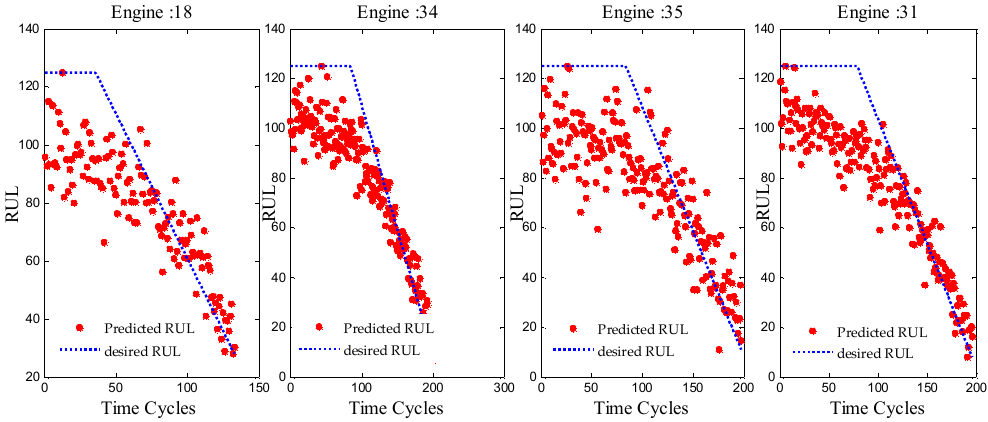
Figure 7. RUL prediction function compared to desired function.